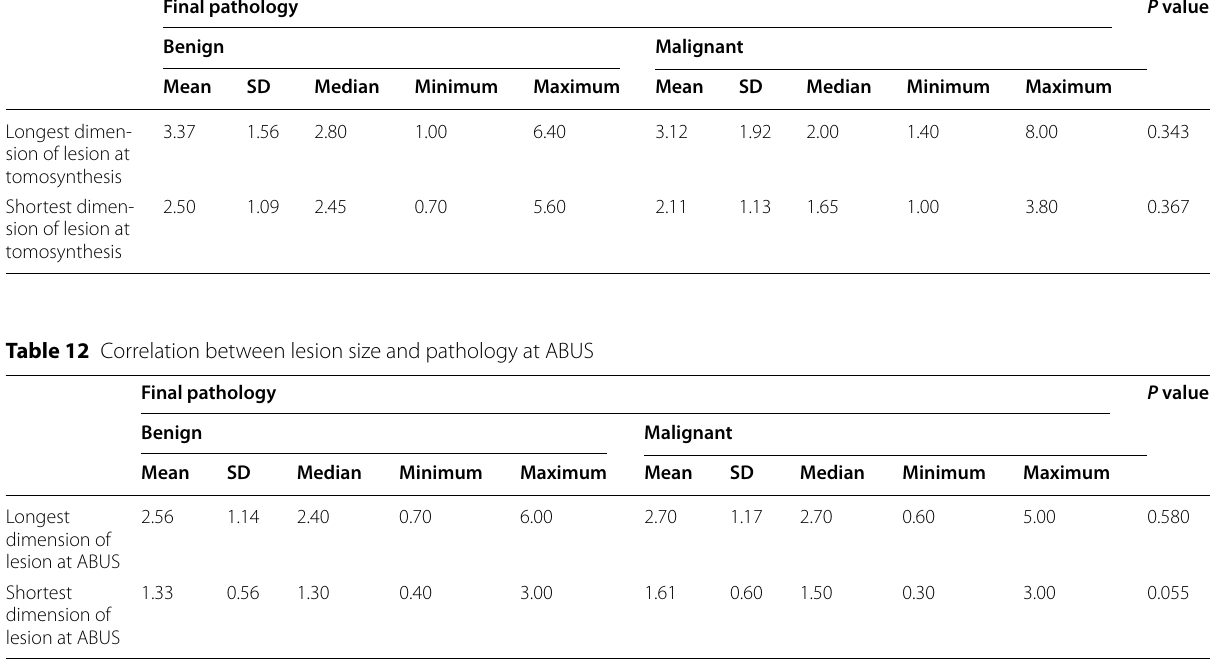
Measure of agreement